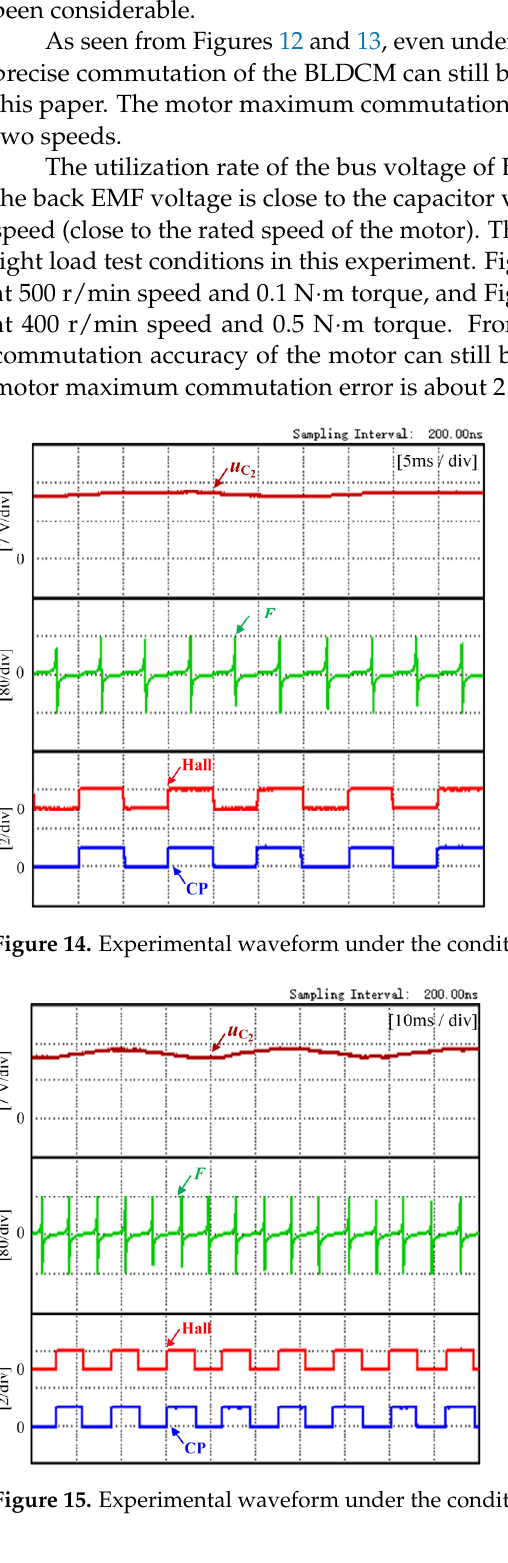
Table 4. Commutation error of the proposed method.